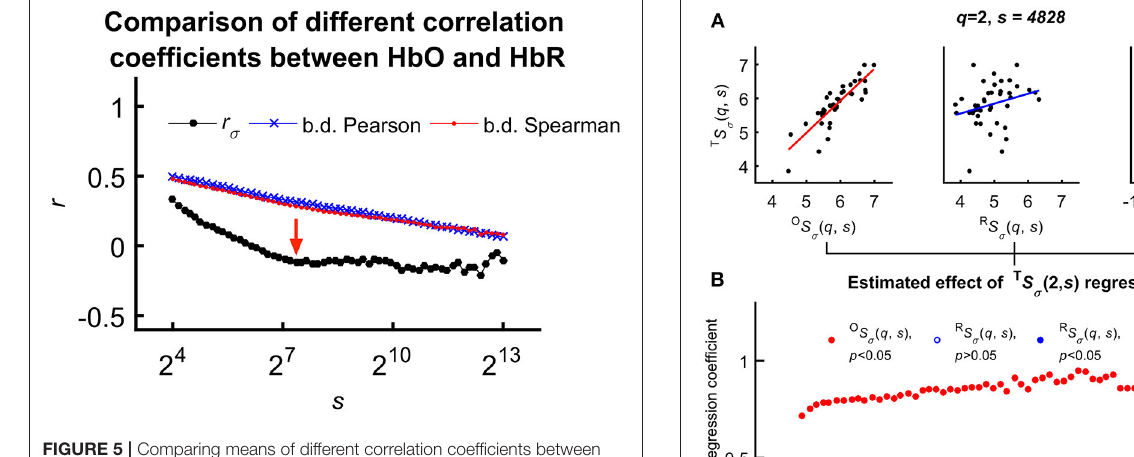
FIGURE 5 | Comparing means of different correlation coefficients between HbO and HbR calculated for all subjects. We explain the less correlated values observed for r σ ( s ) with the effect of calculation order on trends in the signal. In case of the mean Pearson- and Spearman-coefficients, detrending and averaging step come after calculating the correlation effectively neglecting the fundamentally scale-free character of the processes. However, considering fractal scale-wise correlation coefficient, this latter step is the last preceded by averaging of bridge-detrended variances at a given scale. Please also note the characteristic transient—indicated by red arrow—only appearing in r σ ( s ).